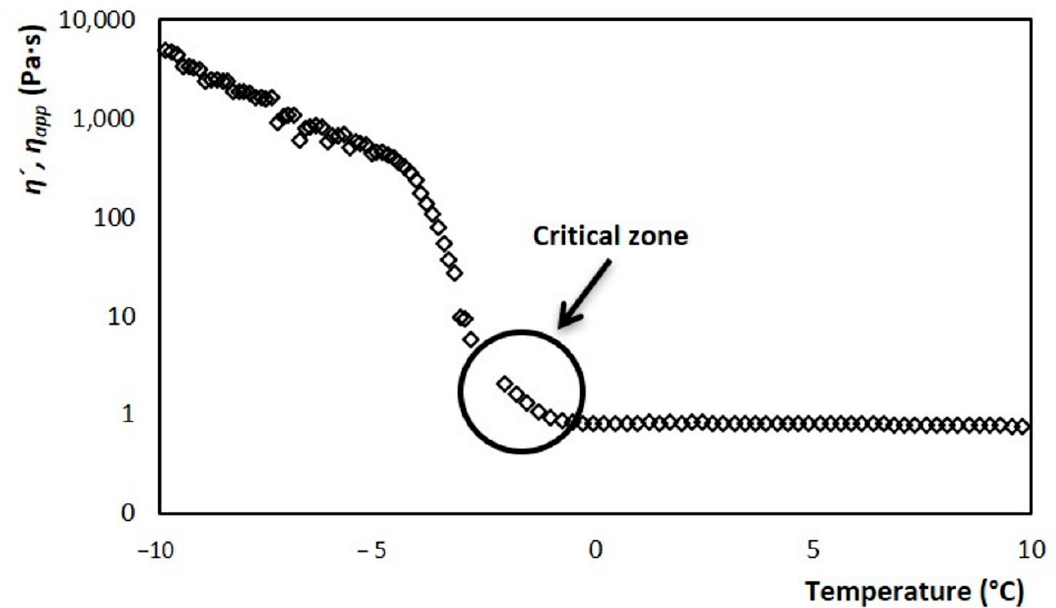
Figure 9. Evolution of dynamic viscosity ( − 10 to − 3 °C) and apparent viscosity ( − 2.5 to 10 °C) of ice cream, with respect to change temperature, with a constant frequency and shear rate from 73.78 s − 1 .